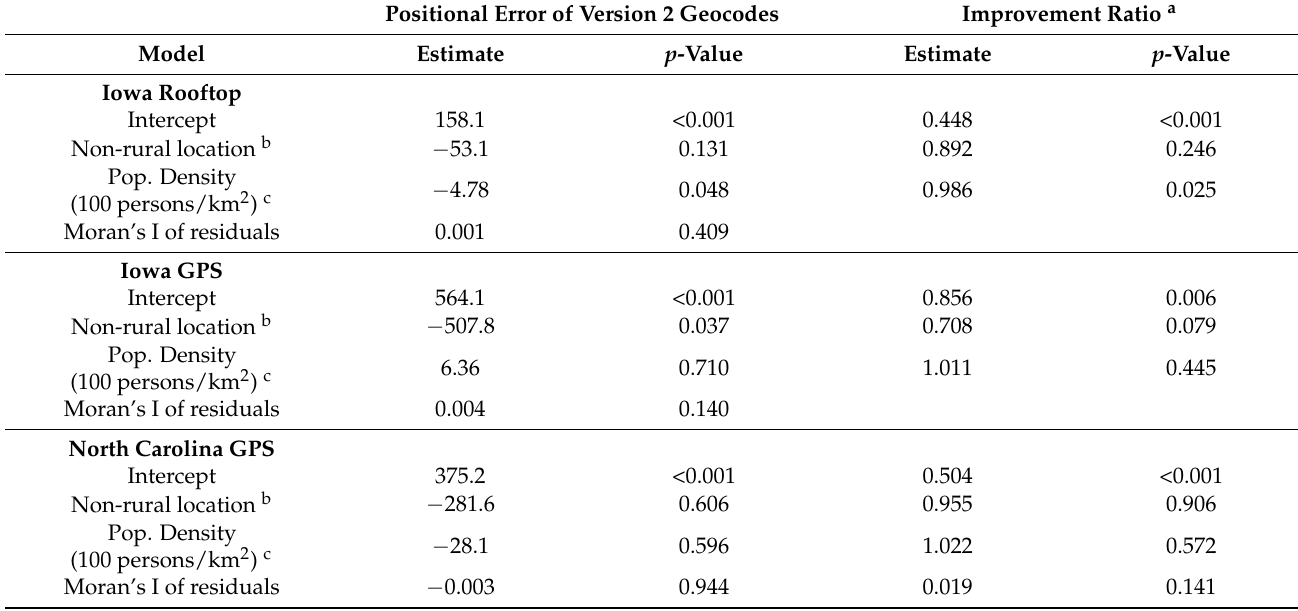
Table 5. Regression models predicting positional error of Version 2 geocodes and the improvement ratio in positional error between Version 1 and Version 2